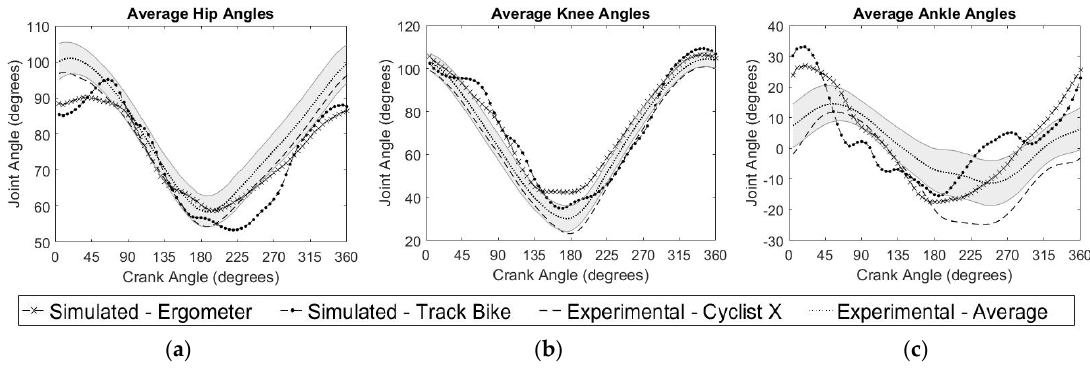
Figure 2. Right leg average joint angles over a pedal stroke for average experimental, Cyclist X experimental, ergometer simulations, and track bike simulations. The shaded area around the “Experimental Average” curve represents the standard deviation. ( a ) Average hip angle with a constant pelvis angle of 45°, 0° is full extension; ( b ) Average knee angle, 0° is full extension; ( c ) Average ankle angle, 0° is perpendicular to shank, positive angle is